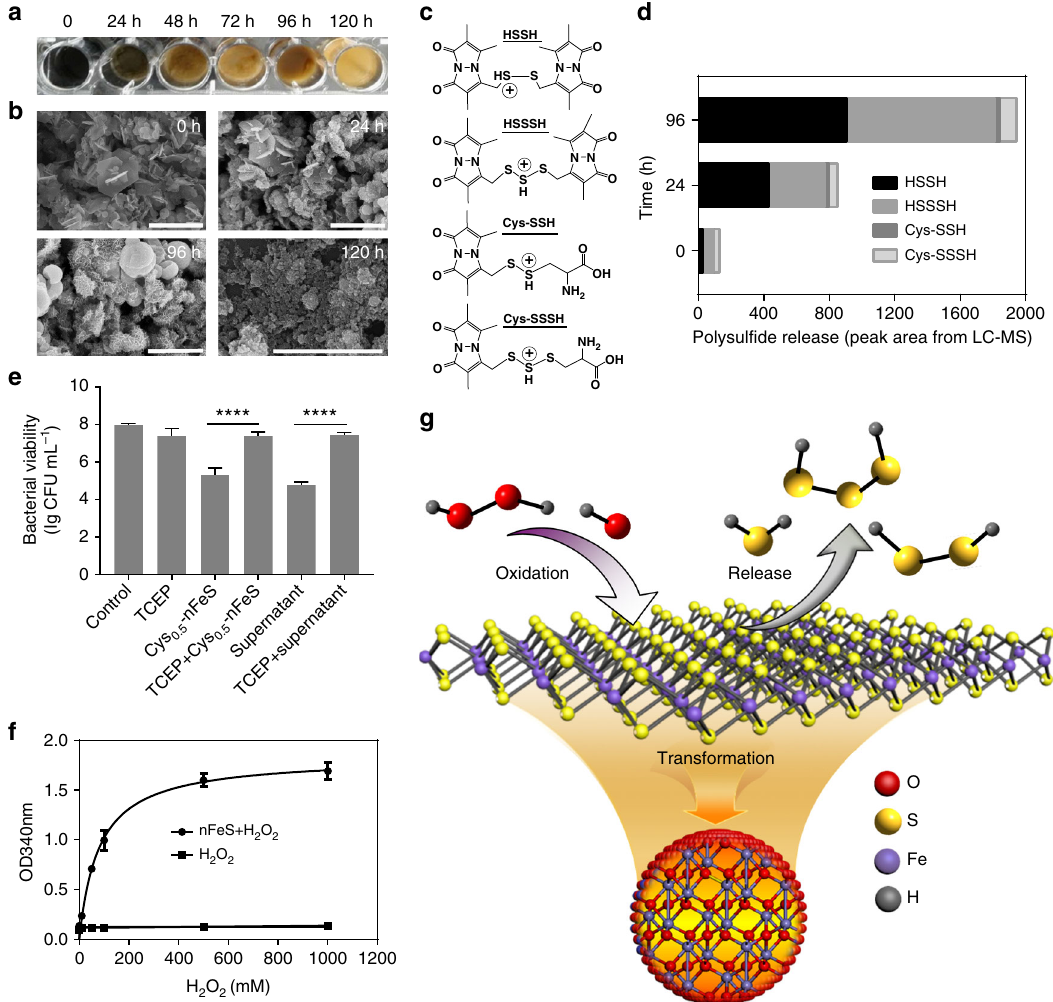
Fig. 3 nFeS releases polysulfanes for antibacterial activity. a Color change of Cys-nFeS incubated in water for different time periods. b SEM image of the nanostructure transformation of Cys-nFeS after incubation in water. Scale bars: 2 µ m. c Fragmentation scheme for polysulfanes identi fi ed from the supernatant after monobromobimane (MBB) derivatization in positive ionization mode. d Comparison of component ratio of polysulfanes in the supernatant by LC – MS/MS. HSSH: H 2 S 2 . HSSSH: H 2 S 3 . e Blocking of antibacterial activity by tris(2-carboxyethyl)phosphine (TCEP). f H 2 O 2 accelerated polysulfane release via catalysis-accelerated release (CAR) effect. g Scheme of polysulfane release from nFeS. Data are shown as the mean ± s.d. Statistical signi fi cance was assessed using unpaired Student ’ s two-sided t -test compared to the control group. ** p < 0.01, *** p < 0.001 and **** p < 0.0001. Mean values and error bars were de fi ned as mean and s.d., respectively. All experiments were performed in triplicate, and representative images